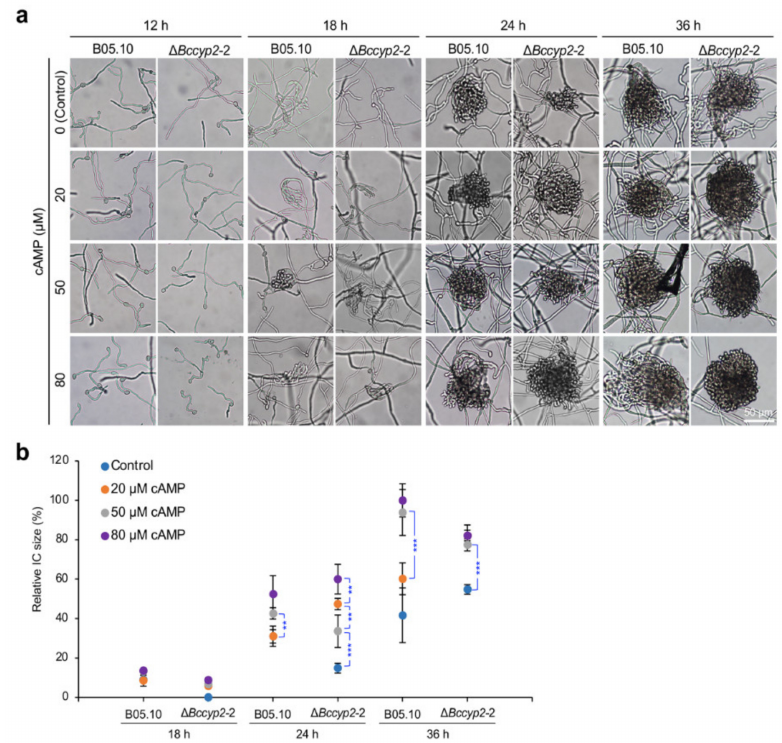
Figure 5. Cyclic adenosine monophosphate (cAMP) restores IC formation of the BcCYP2 deletion mutants. ( a ) Exogenous cAMP rescues defects of IC formation of the ∆ Bccyp2 mutants. Conidial droplets (10 µ L) supplemented with cAMP (0, 20, 50, 80 µ M) were inoculated on glass slides and incubated in the dark for 12, 18, 24 or 36 h; the development of ICs was then photographically documented. ( b ) Quantitative analysis of the sizes of ICs produced by the tested strains. IC: Infection cushion. **, ***: significance at p < 0.01 and 0.001,